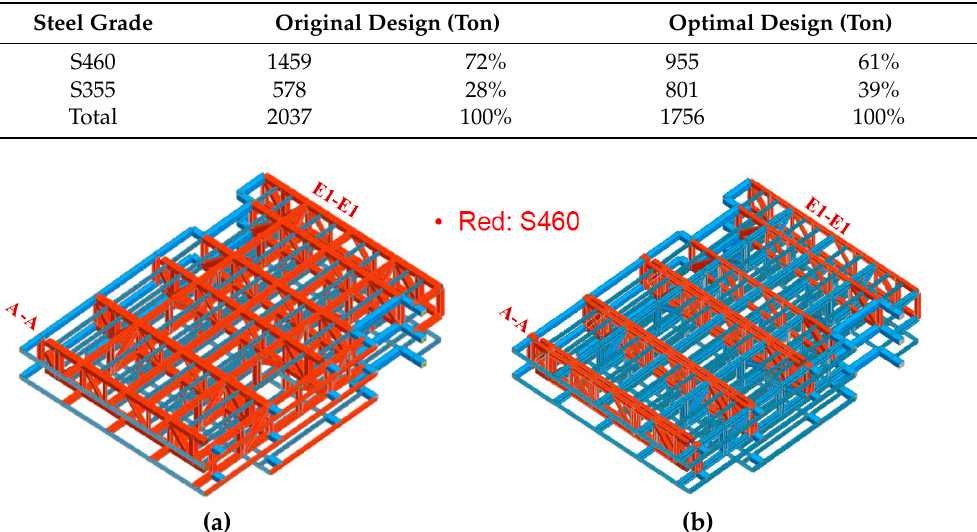
Table 3. Comparison of steel grade used.